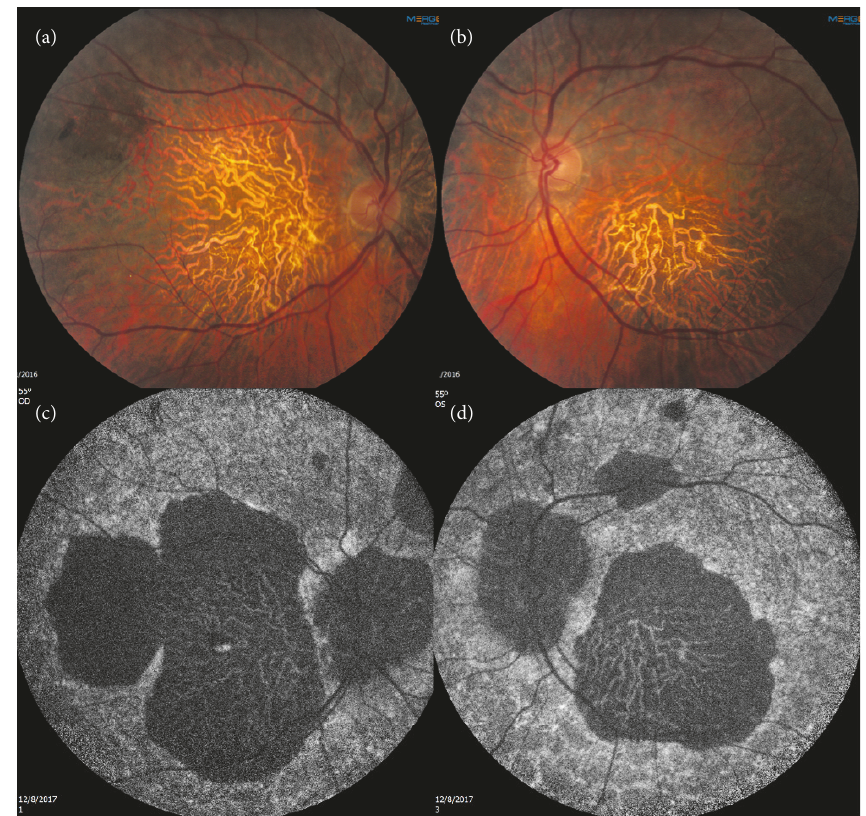
Figure 1: (a) and (b) Color fundus photo demonstrating macular atrophy and surrounding pseudodrusen OU. (c) and (d) FAF reveals hypoautofluorescence in areas of atrophy OU with a central island in the right